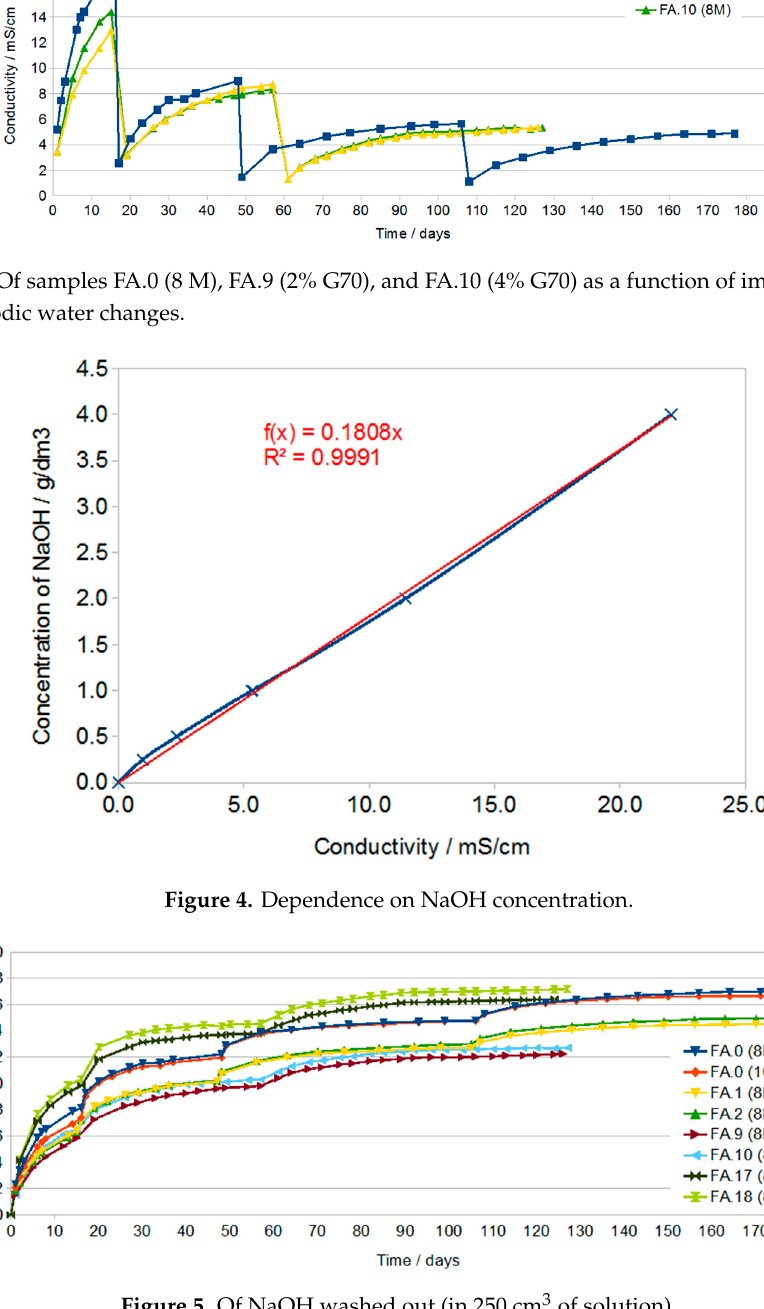
Figure 3. Of samples FA.0 (8 M), FA.9 (2% G70), and FA.10 (4% G70) as a function of immersion time with periodic water changes.